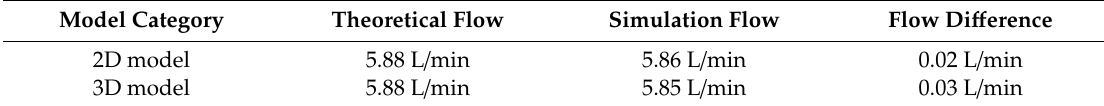
Table 1. Model verification parameter comparison table.